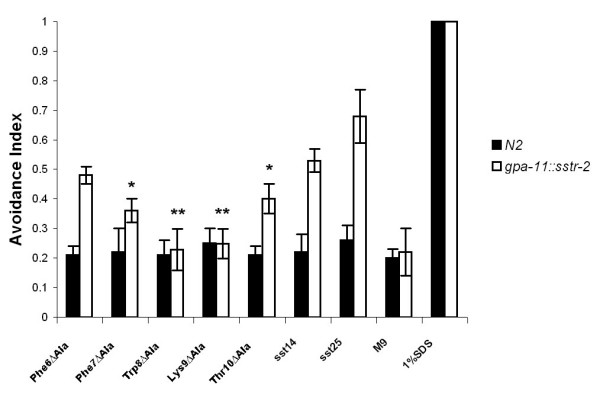
Identification of SST-14 residues involved in Sstr2 activation. Sstr-2 transgenic animals were tested for response to SST-14 and five variants with single alanine substitutions at residues 6–10. No avoidance behaviour was observed with 25 μM of Trp8Δ Ala and Lys9Δ Ala SST-14 analogues while residual avoidance behaviour was found with Phe7Δ Ala and Thr10Δ Ala. Sstr2 transgenic animals were repelled by the Phe6Δ Ala analogue, indicating that Phe6 is not essential for receptor:ligand interaction. Each data point represents an average of at least five independent assays for wild type and each respective strain. Error bars denote the standard error of the mean. Asterisks indicate a statistically significant difference between the avoidance index of the transgenic animals for the Trp8Δ Ala and Lys9Δ Ala analogues and native SST-14 agonist (*p ≤ 0.05, **p ≤ 0.01).